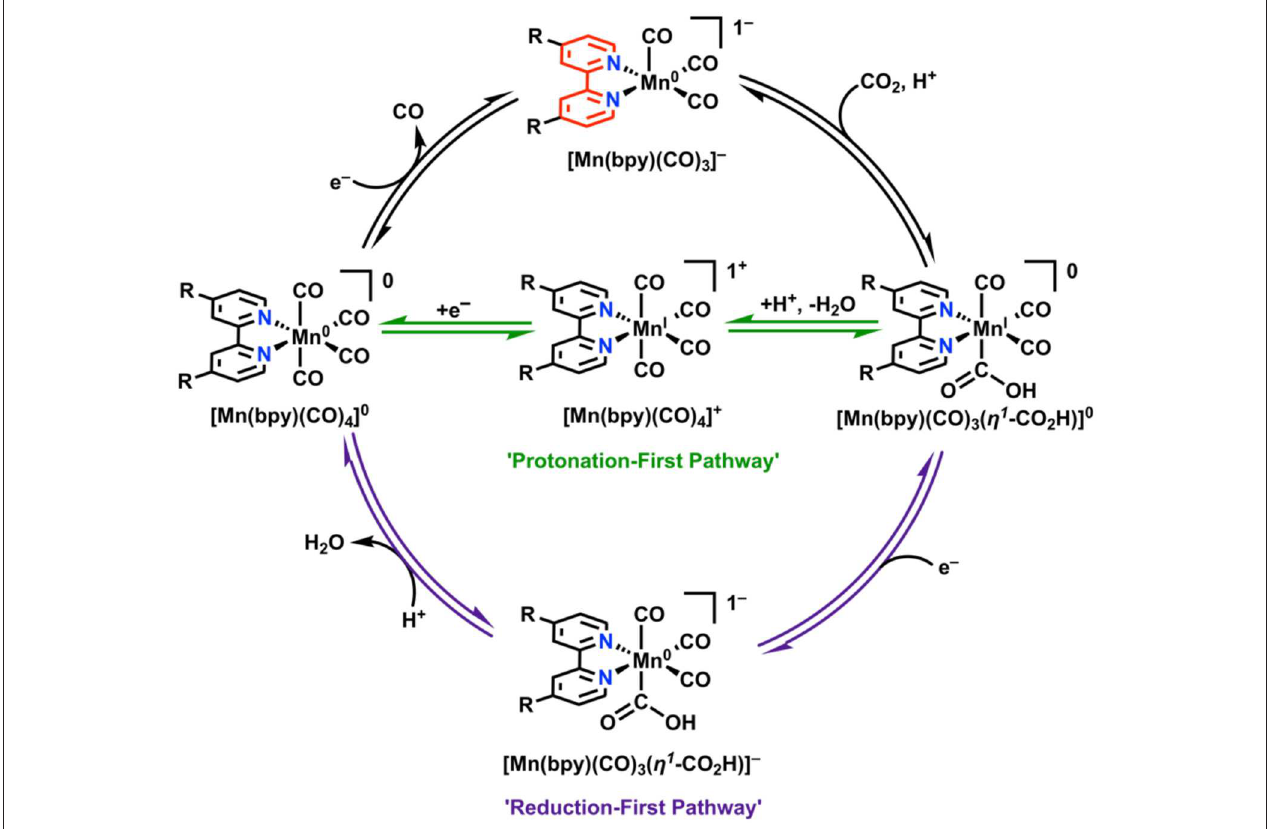
FIGURE 10 | “Protonation-first” and “reduction-first” pathways for CO 2 reduction by Mn(bpy)(CO) 3 X (Riplinger et al.,